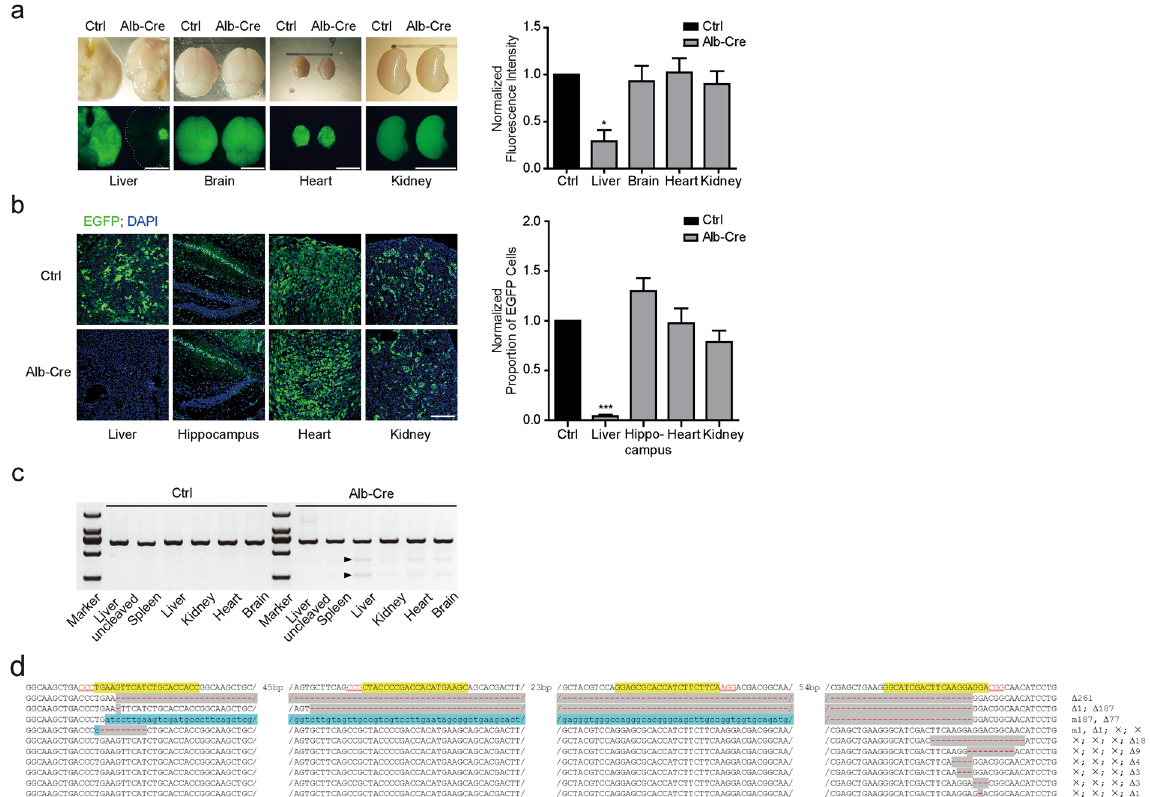
Figure 2. Tissue-specific mutations of EGFP in sgRNAs EGFP - LSL - Cas9 ; EGFP ; Alb-Cre mice. ( a , b ) EGFP fluorescence of liver was almost completely eliminated in sgRNAs EGFP - LSL - Cas9 ; EGFP ; Alb - Cre (Alb-Cre) mouse. Control (Ctrl) was sgRNAs EGFP - LSL - Cas9 ; EGFP mouse. The right panels quantified fluorescence. ( a ) Paired t-test. liver, * p = 0.0109; brain, p = 0.8084, not significant (ns); heart, p = 0.8893, ns; kidney, p = 0.3101, ns. n = 3. Scale bar, 5 mm for ( a ); 200 μ m for ( b ). ( c ) T7EN1 assay showed obvious digested bands (arrows) indicating mutations in the lane of Alb-Cre positive mouse, while none in Cre negative mouse (Ctrl). M, maker. ( d ) Mutated EGFP sequences from sgRNAs EGFP - LSL - Cas9 ; EGFP ; Alb - Cre mouse liver. PAM (Red), sgRNAs targeting sites (yellow grounding), deletion (grey grounding) and base changing (blue grounding) are shown. Δ , deletion; m, mutation; × , no mutation in the presenting sequence. Numbers following the symbols are base quantity of